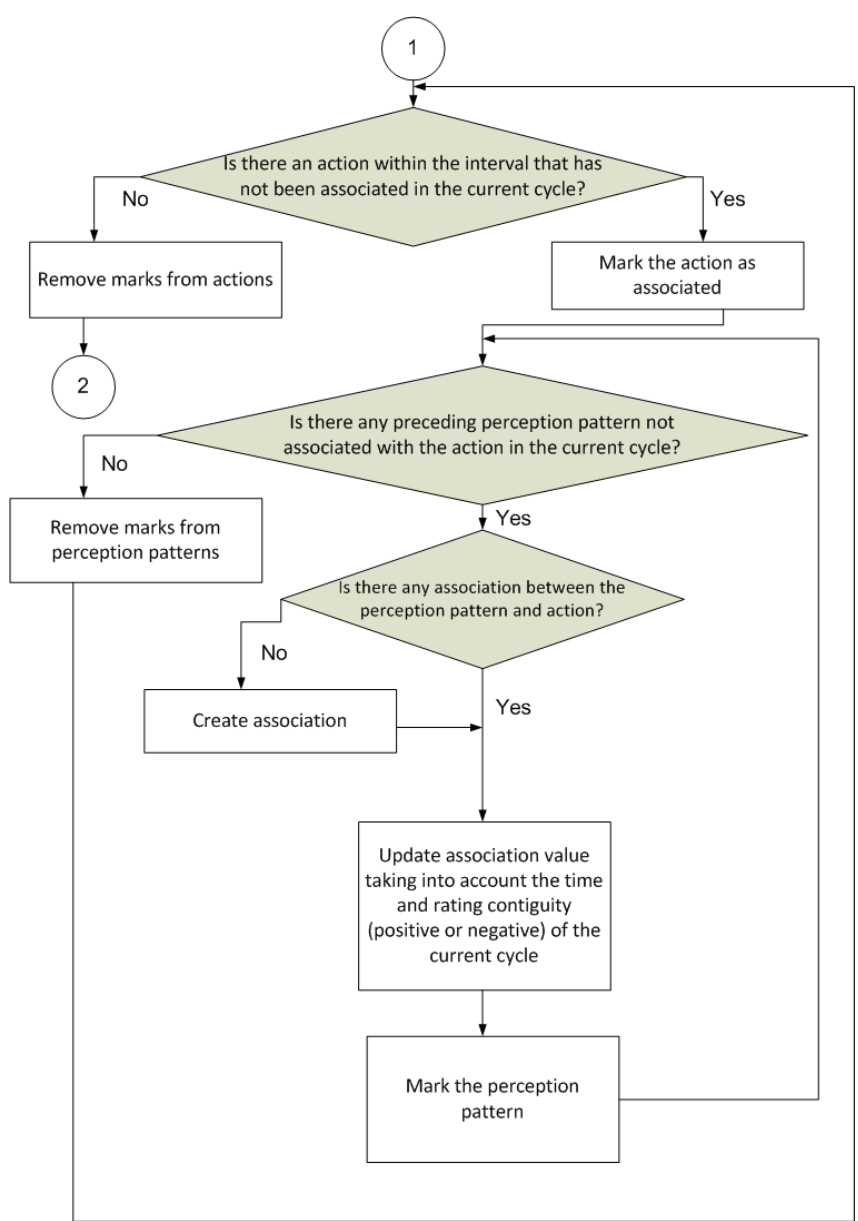
Figure 4. Association updating (1 is the initial state of this diagram; state 2 continues in Figure